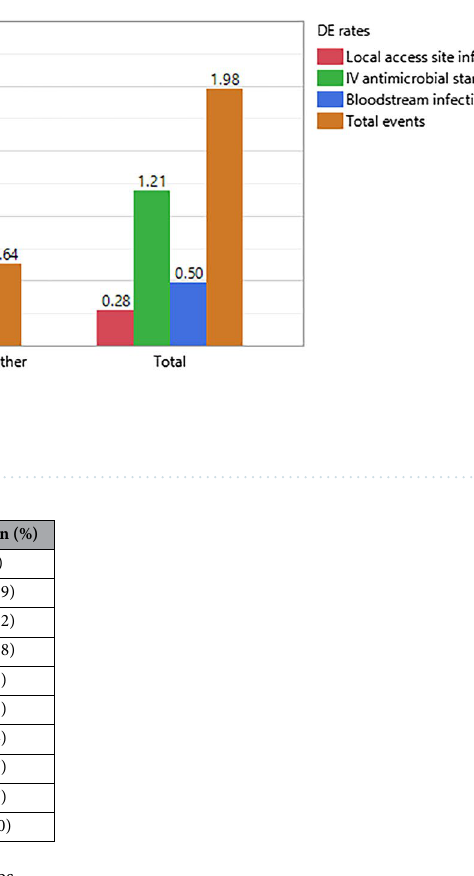
Table 2. Isolated microorganisms from blood